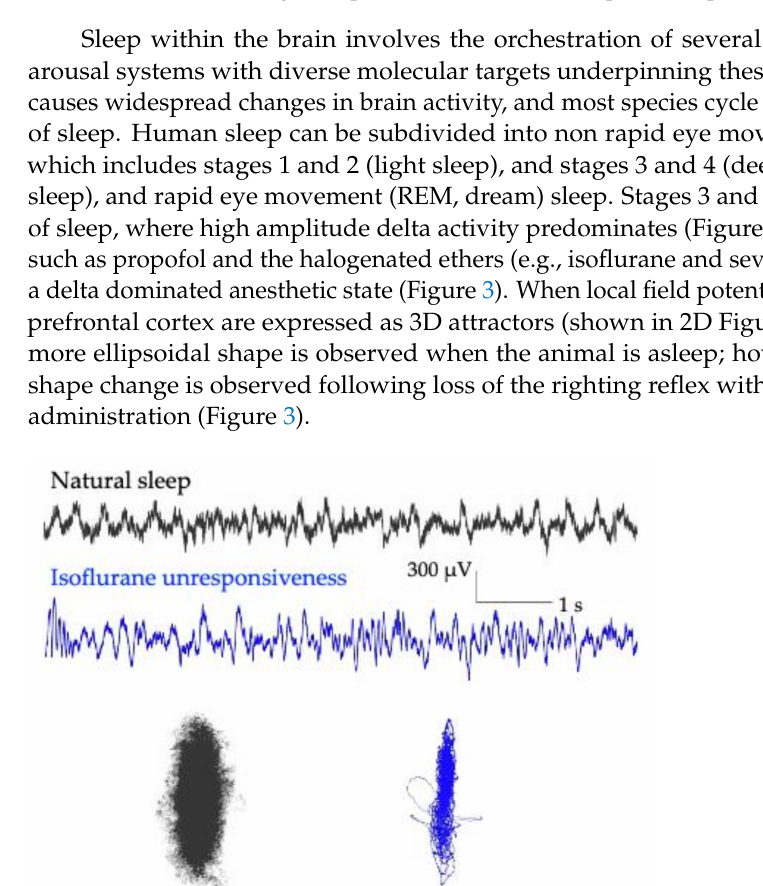
Figure 2. EEG attractors from rodent prefrontal cortex, showing how the geometrical shape changes with anesthesia exposure. Three-dimensional, time-delayed embeddings (attractors) change shape as rodents are exposed to deepening levels of anesthesia. Attractors flatten from inflated spheres during awake states (red), to flatter ellipsoids as anesthetic depth increases during sedation (black) and flatten even further during unresponsive (blue) states. Adapted with permission from Reference [4].